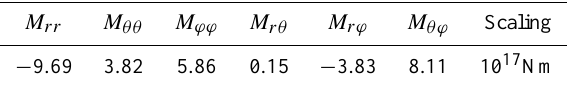
Fig. 4. Computational mesh for benchmark simulations using the 1-D isotropic PREM model (density values are color coded). For visualization purposes the mesh is separated into 15 chunks. Table 2. CMT solution of the 2009 Norwegian Sea